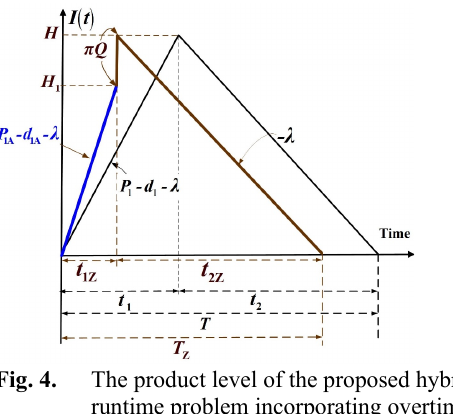
Fig. 4. The product level of the proposed hybrid manufacturing runtime problem incorporating overtime and scrap, but with no stochastic breakdowns, (in thicker lines) compared to the same problem with scrap items only (in thinner lines)